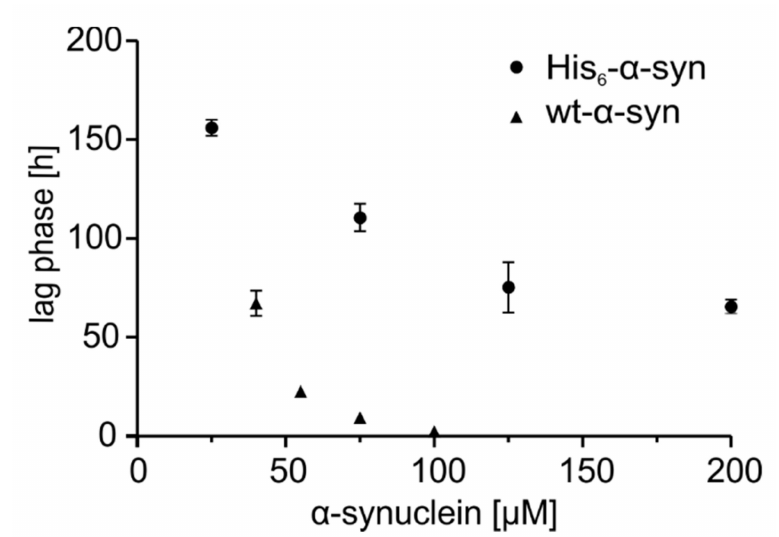
Figure 2. Comparison of lag phase duration obtained from aggregation kinetics of His 6 - α -synuclein (dots, 25 µ M, 75 µ M, 125 µ M, 200 µ M) and wt- α -synuclein (triangle, 40 µ M, 55 µ M, 75 µ M, 100 µ M) measured by ThT fluorescence at pH 7.0 ( n =